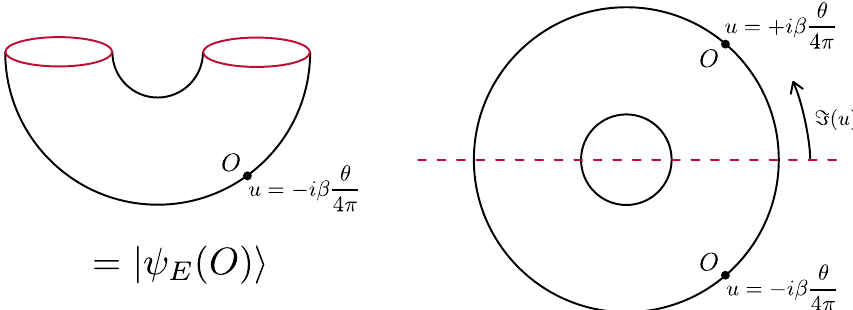
( O ) 〉 and its norm in u coordi- E ( O ) 〉 in the extended Hilbert E ( O ) 〉 . The red dashed line indicates where we cut the E